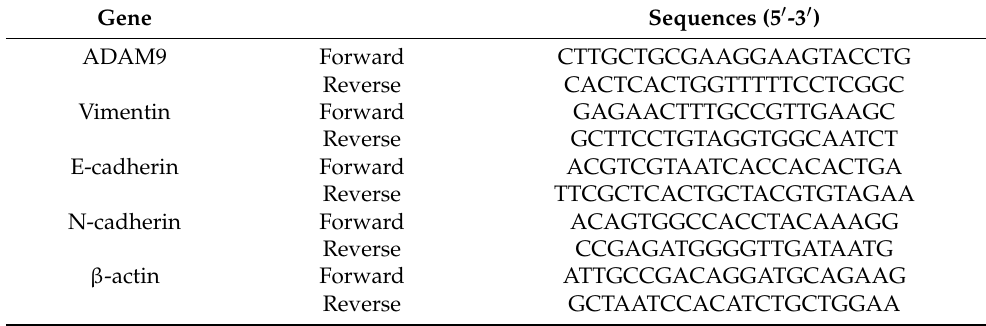
Table 1. Primers used for RT-qPCR.